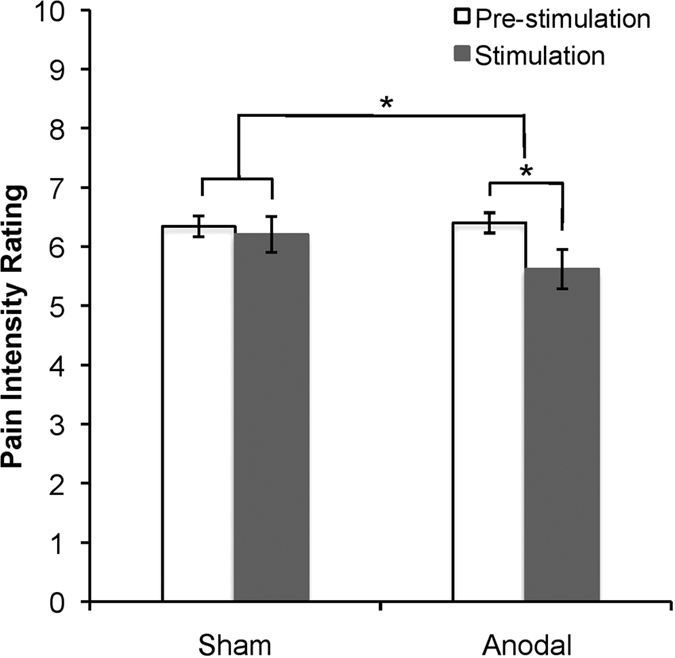
Behavioral pain response to L-DLPFC tDCS.Pain intensity ratings were recorded immediately before and after sham and anodal tDCS. The numerical rating scale was anchored between the extremes of 0 (“None”) and 10 (“Worst Imaginable”). Greater analgesia was found with anodal tDCS compared to sham tDCS (ANOVA stimulation by time interaction effect F(1,17) = 4.460, p < 0.05). A significant reduction was also observed in anodal tDCS trials (p = 0.04) but not in sham tDCS trials (p = 0.65). (*indicates p < 0.05).